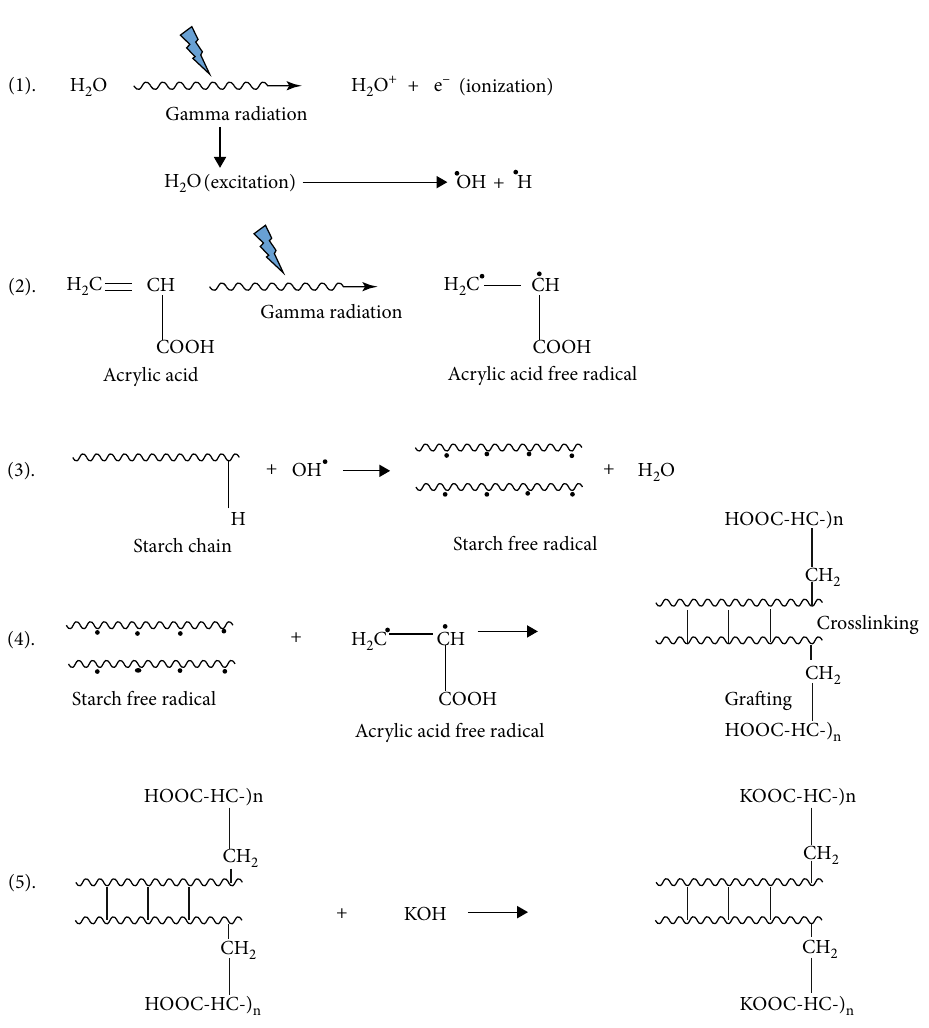
Figure 1: Schematic view of a cross-linked polymer network.